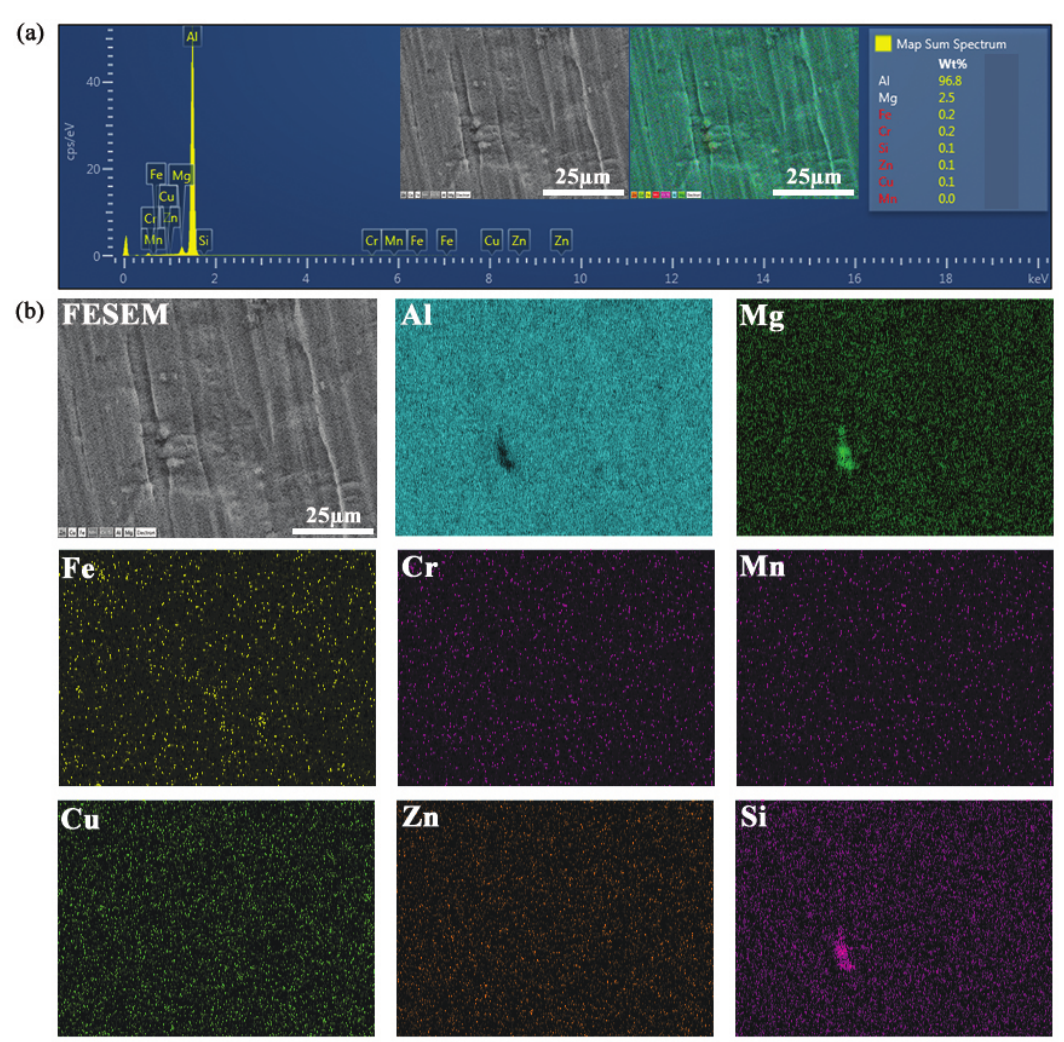
Figure 2. Energy dispersive X–ray spectroscopy (EDS) analysis ( a ) Element spectrum corresponding to AA5052-H32 material; ( b ) EDS elemental mapping images showing the distribution of chemical